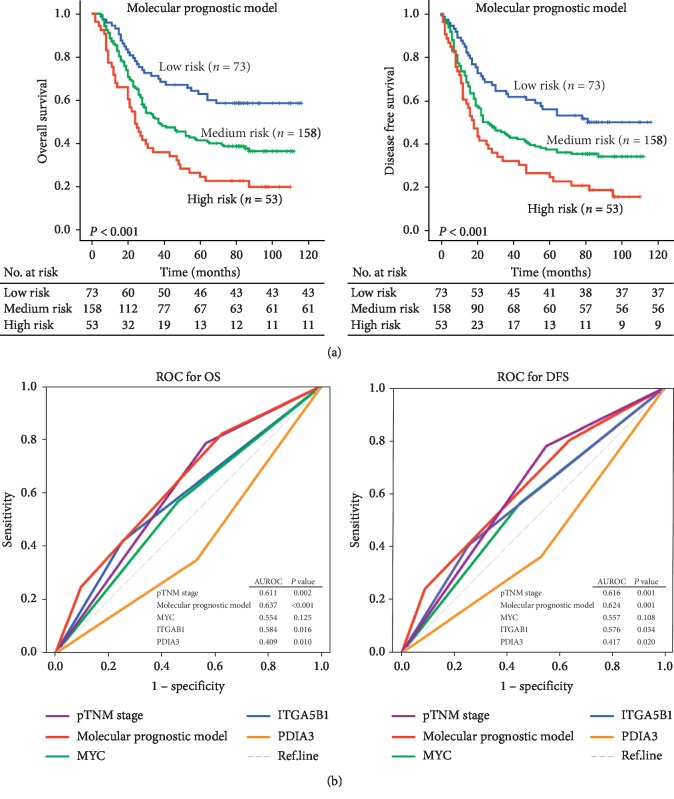
Predictive value of the molecular model. (a) K-M survival curves showing that the OS and DFS had a striking contrast between the ESCC patients in low-, medium-, and high-risk groups. (b) Receiver operating characteristic (ROC) curve was used to evaluate the ability of the molecular model for OS or DFS compared with each biomarker alone or the pTMN-stage.